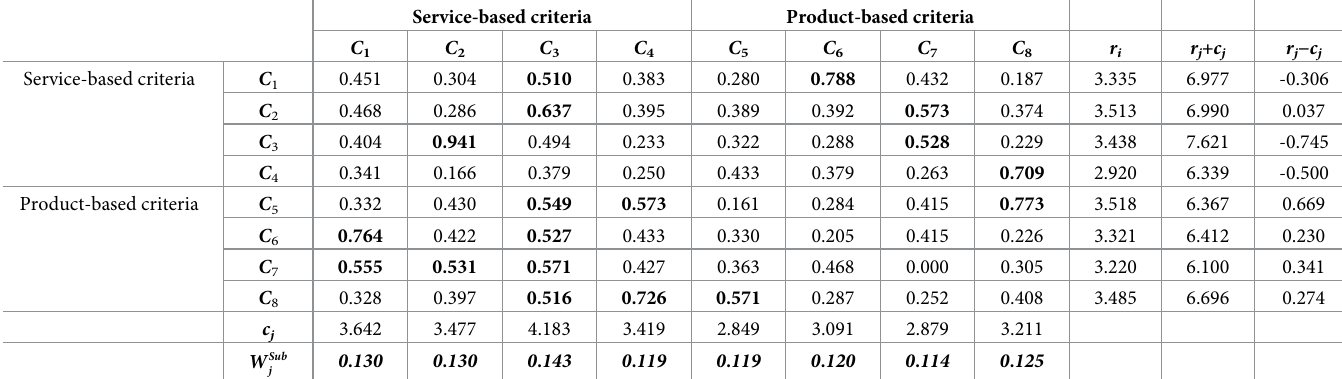
Table 7. Total-influence matrix and subjective weights.